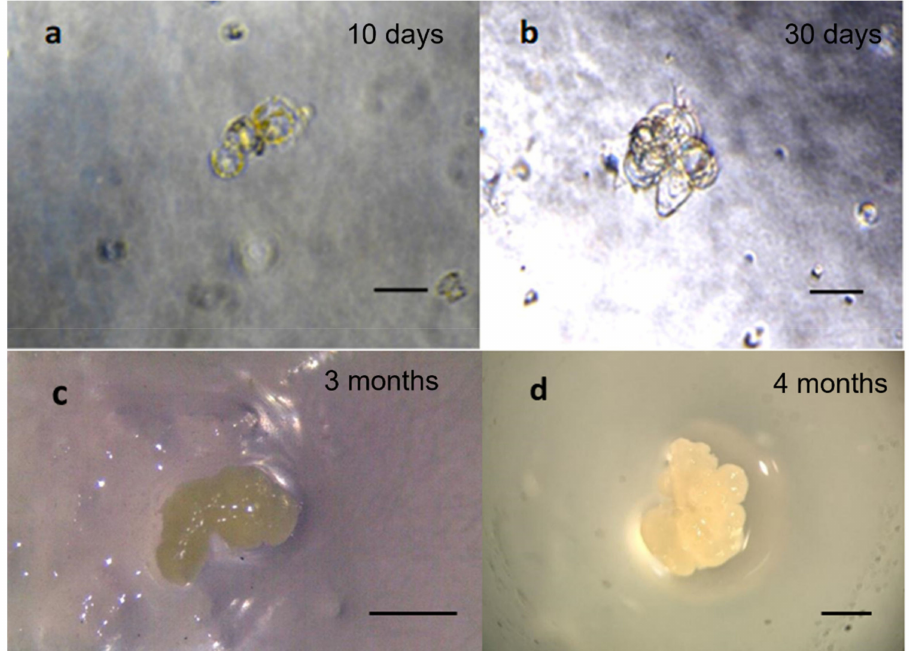
Figure 3. General overview of protoplast development into embryogenic callus in European chestnut observed on C2 medium. ( a ) First cellular divisions after 10 days; ( b ) microcolonies after 30 days; ( c ) embryogenic callus after 3 months of culture; ( d ) embryogenic callus after 4 months. Observations were obtained using the stereomicroscope Leica-Wild Heerbrugg M8. Scale bar = 1